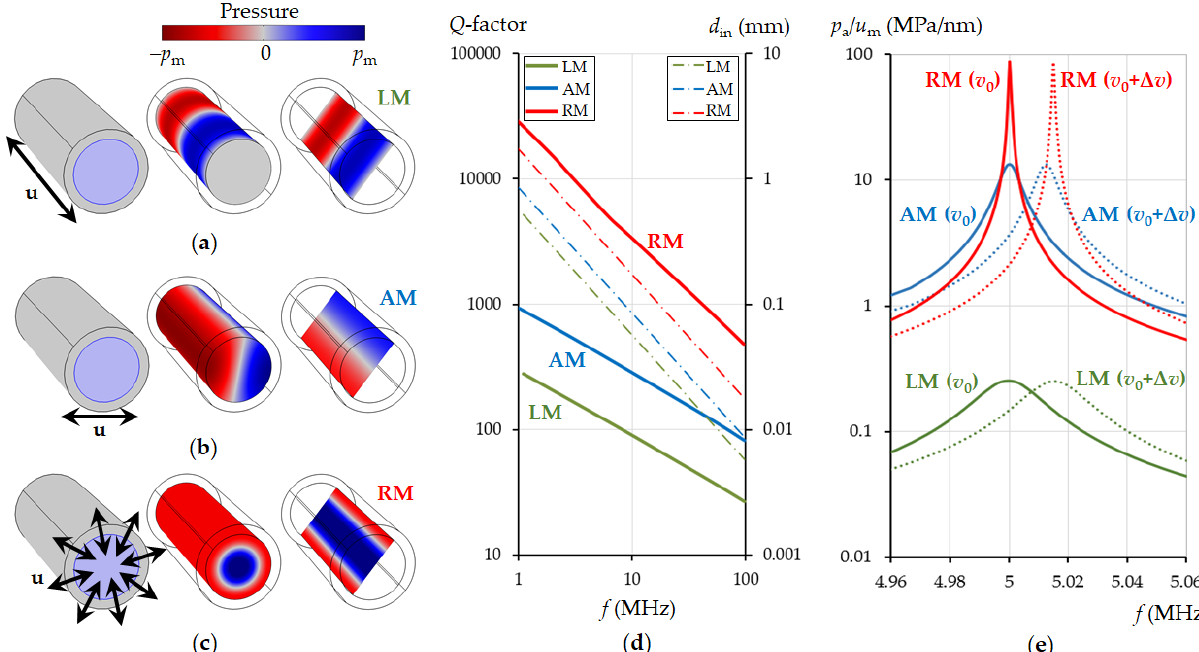
Figure 2. Resonant mode excitation in a cylindrical resonator and their Q-factors: pressure distribution in a liquid for the longitudinal ( a ), azimuthal ( b ) and radial ( c ) mode according to the action of mechanical displacement in the solid as shown by arrows. Dependence of the Q-factor of the eigenmodes on the resonance frequency ( d left axis) and the corresponding values of the inner diameter of the cylindrical resonator ( d right axis). Frequency dependence of the volume-averaged absolute pressure in the liquid in relation to the magnitude of the exciting mechanical displacement at 5 MHz resonance ( e ). The calculations were performed for water at a temperature of 20 °C, v 0 = 1481 m/s (solid lines), ∆ v = 5 m/s (dotted lines).